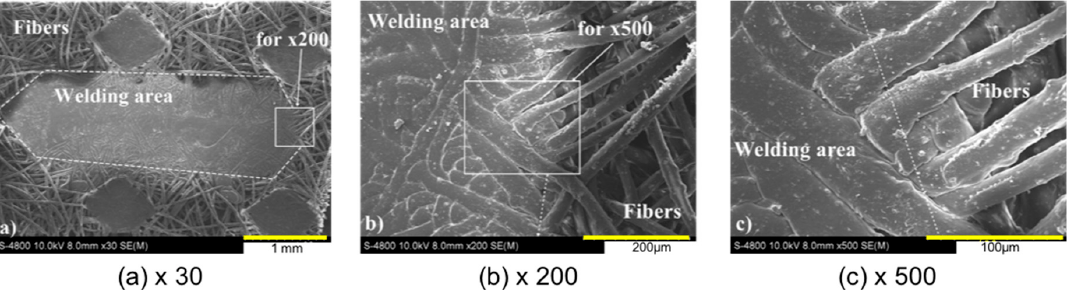
( a ) ×30, ( b ) ×200, and ( c ) ×500.